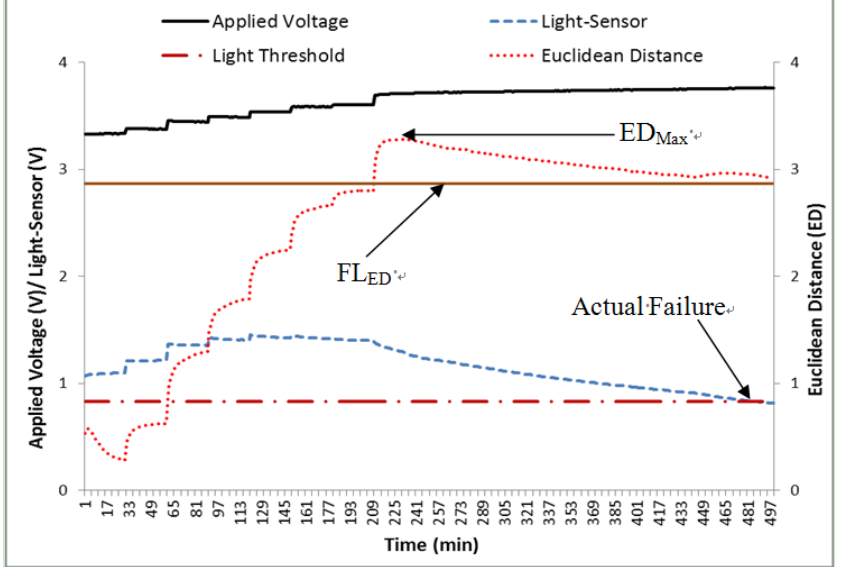
Figure 16. ED history and the ED failure limit for LED test data in the Figure